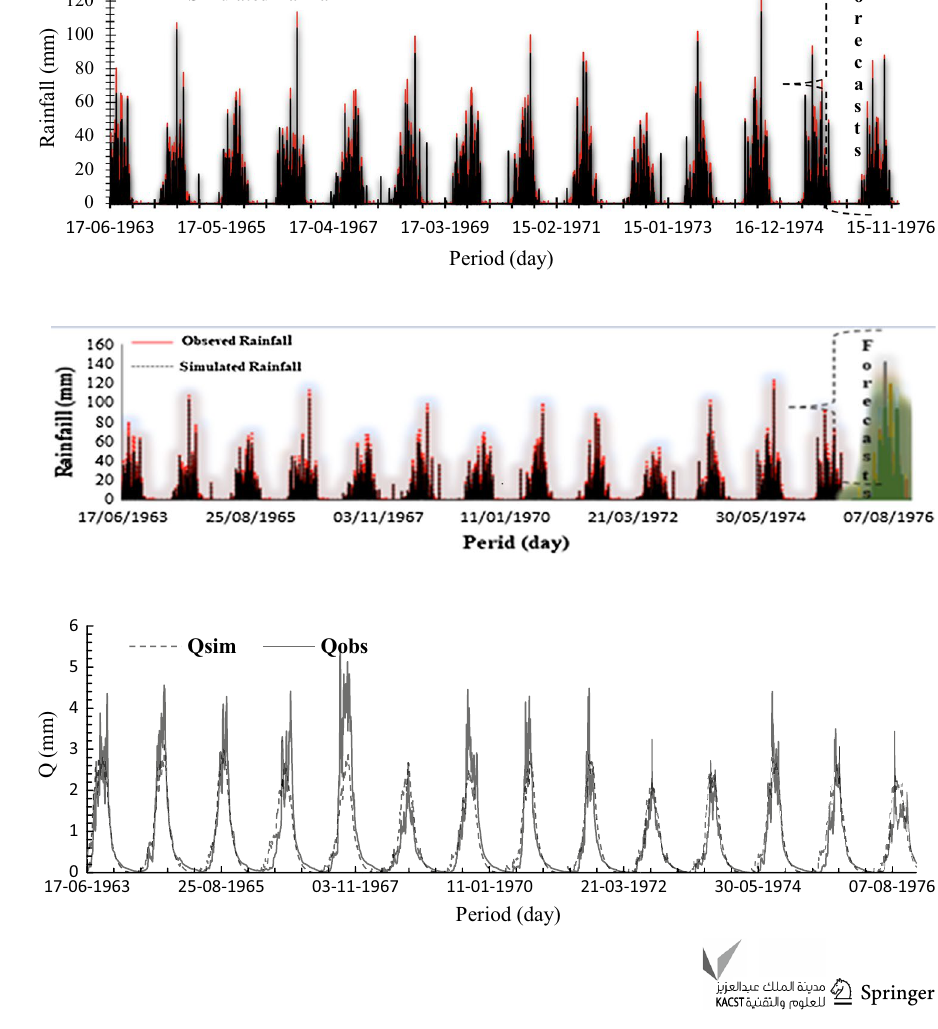
Fig. 4 Evolution of determin- istic simulations and forecasts against observations